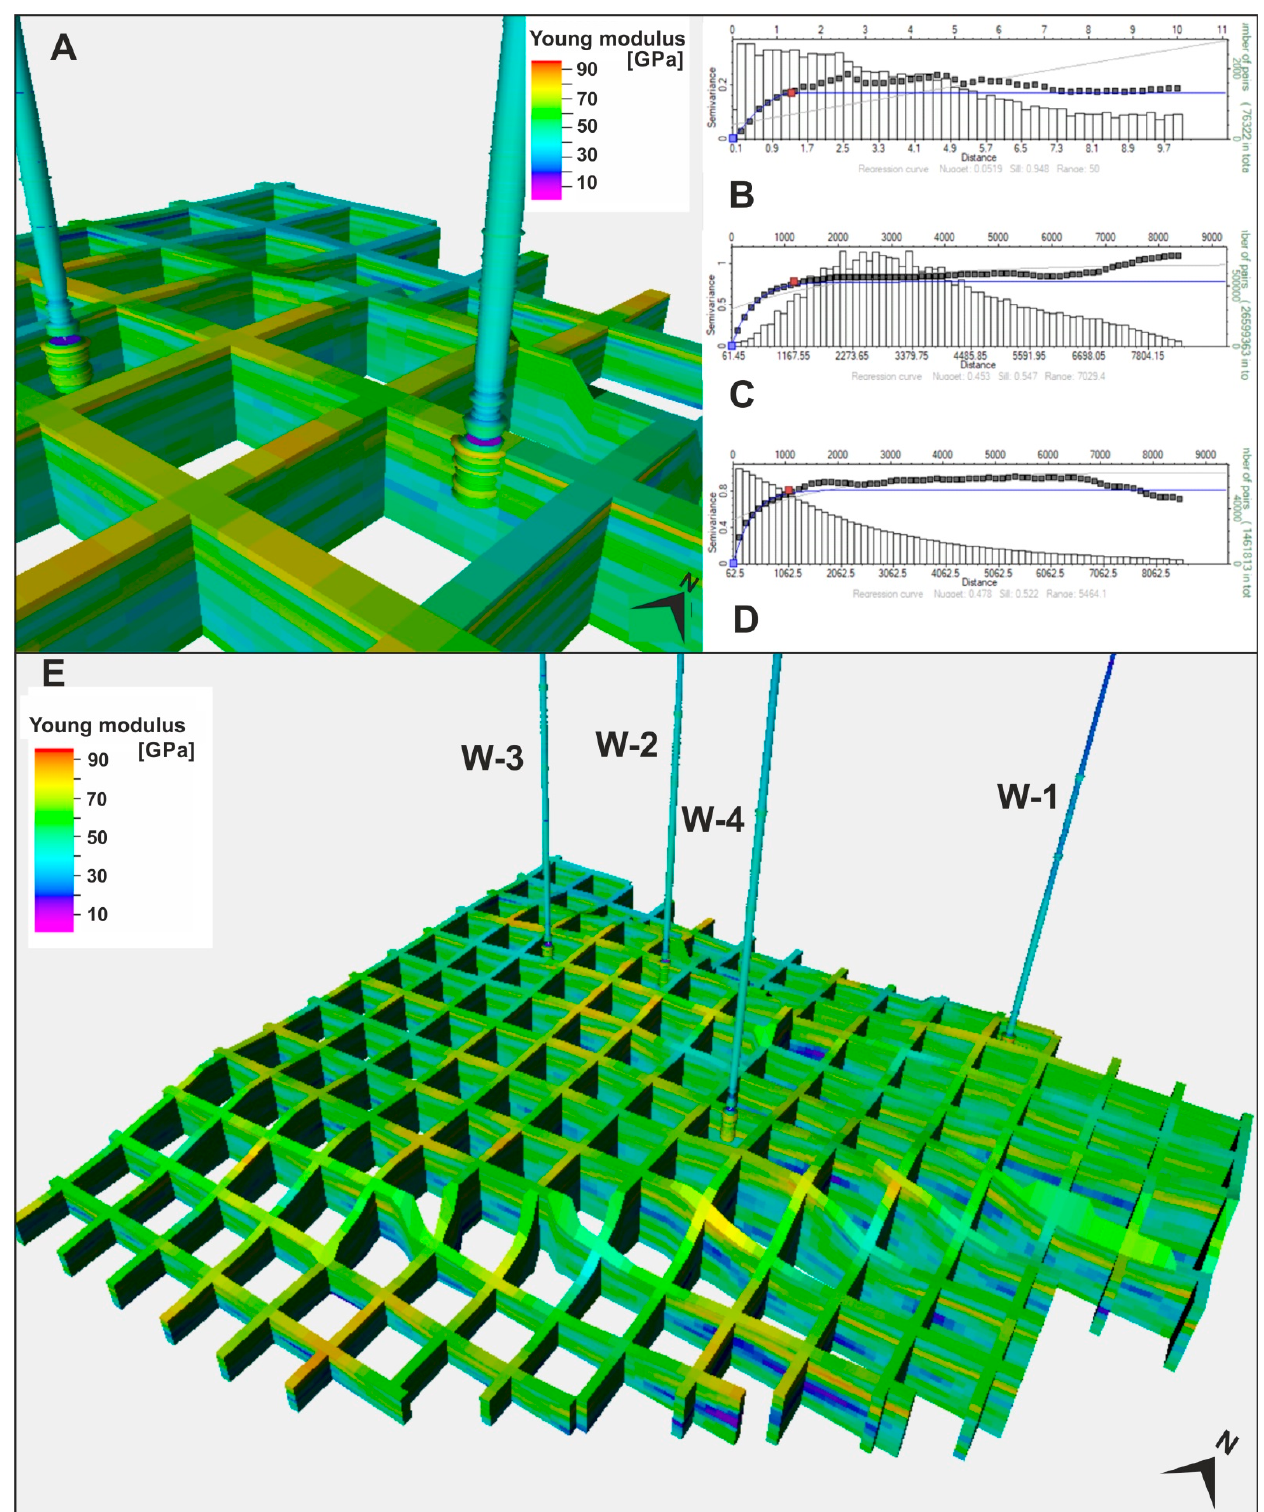
Figure 10. Diagram depicting different stages of the development of 3D parametric models: upscaling of well-log data ( A ), geostatistical analysis obtaining the vertical relationship ( B ), and horizontally in the direction of the highest ( C ) and lowest ( D ) correlation, and the calculated distribution of the parameters in 3D space ( E ).